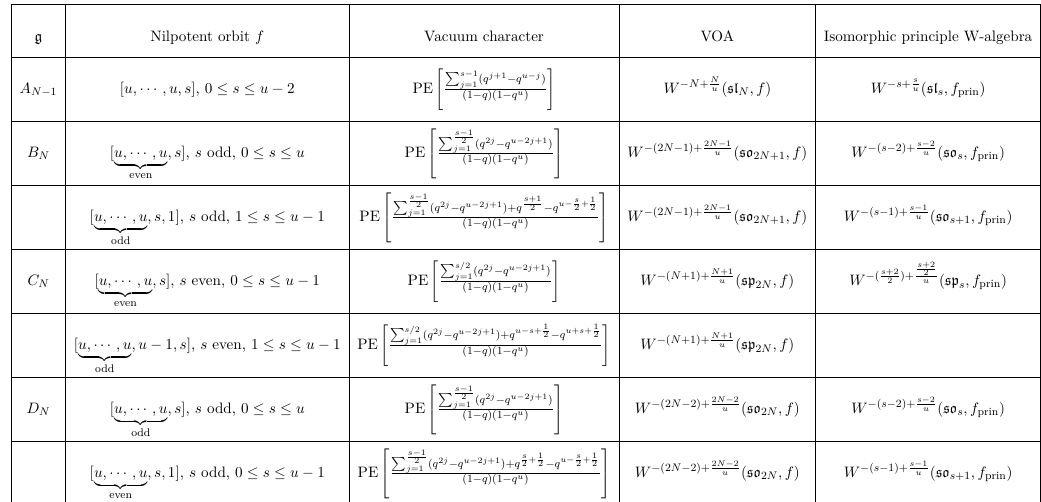
Table 12 . Vacuum characters for W-algebra W − h ∨ + h is an odd integer and ( u, h ∨ ) = 1 .